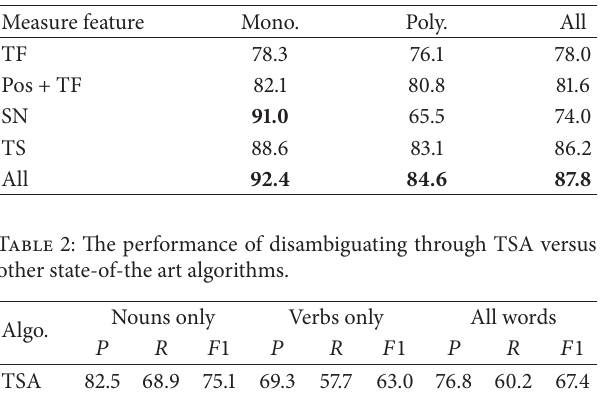
Table 1: The performance of the topic identification based on extracting topic discriminative terms.